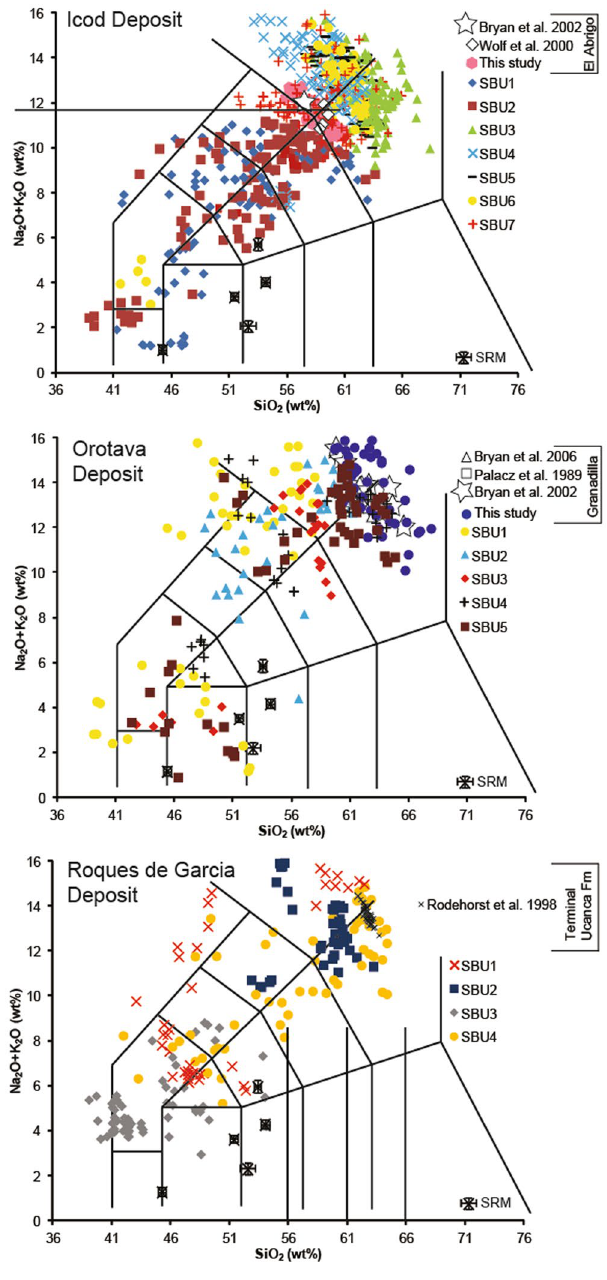
Figure 4. Compositions of volcanic glasses recovered from sub-units of the Icod, Orotava and Roques de Garcia deposits from Tenerife plotted on Total Alkali-Silica (TAS) diagrams. The Icod deposit represents a collation of data from sub-units from core sites from Agadir Basin and the Madeira Abyssal Plain (data from Hunt et al . 7,12,49 and Supplementary 2 inc. 283 new analyses from core D11813 in the Madeira Abyssal Plain), while Orotava and Roques de Garcia subunits are only sampled in the Madeira Abyssal Plain (data from Hunt et al . 38 and Supplementary 2 inc. 150 new analyses from core D11813 and 42 new analyses from D11814 in the Madeira Abyssal Plain respectively). Compositions of Abrigo, Granadilla, and Ucanca ignimbrite glasses and whole rock samples were collated from published work (tephra deposit 1.00–1.12 Ma in ODP 953, Rodehurst et al . 1998) and new glasses analyses of the Abrigo (41 new analyses) and Granadilla (47 new analyses) ignimbrites from this study are also plotted for comparison (data from Supplementary 3). Additional composition data of ignimbrite glasses collated from literature 44,45,52,66–68 . Figure show that volcanic glasses explosive volcanic eruptions, including caldera collapse, proposed as being coeval with landslide are only present in the later sub- units, and not present in the initial submarine stages. SBU stands for